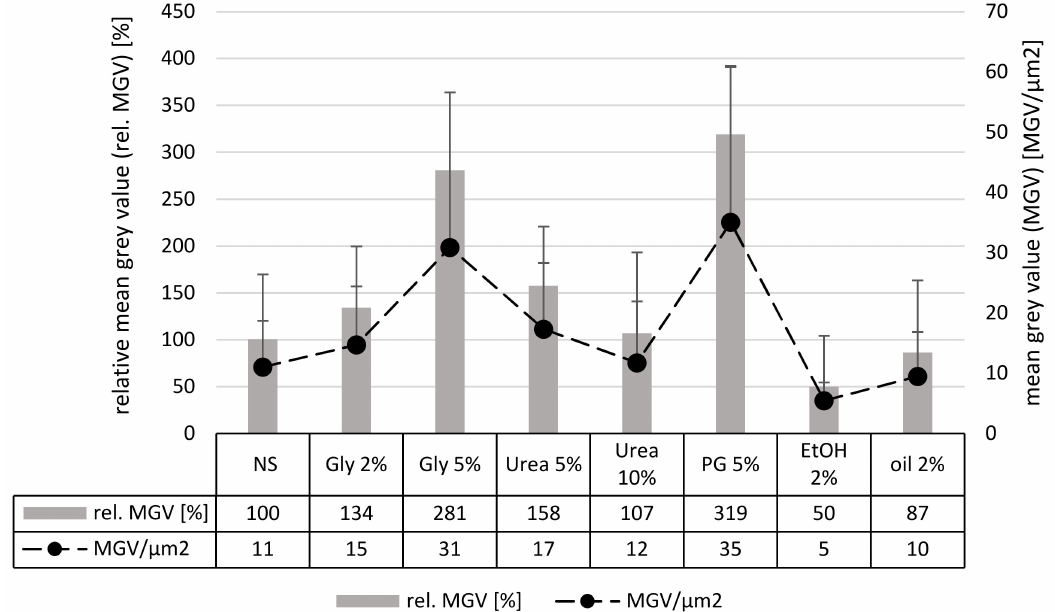
Figure 5. Influence of excipients on the penetration e ffi cacy of curcumin determined by digital image analysis. MGV / µ m 2 = mean grey value per µ m 2 skin—representing the total amount of penetrated curcumin; rel. MGV [%] = relative amount of penetrated curcumin in comparison to the MGV from the nanosuspension without